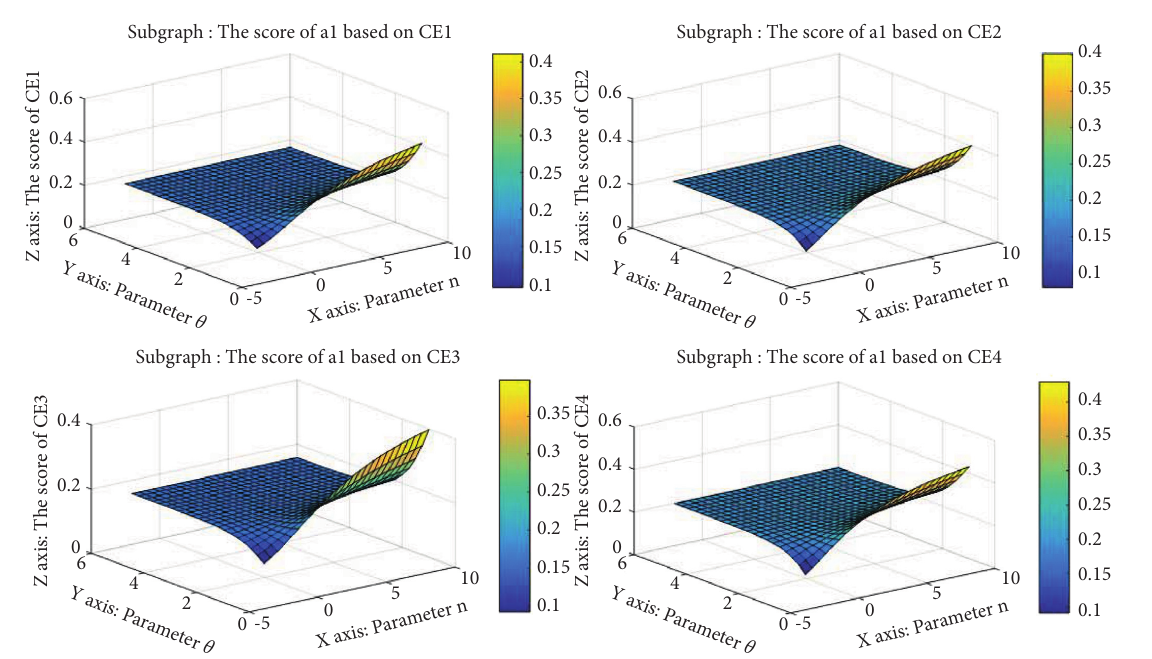
Figure 2: Score of alternative a